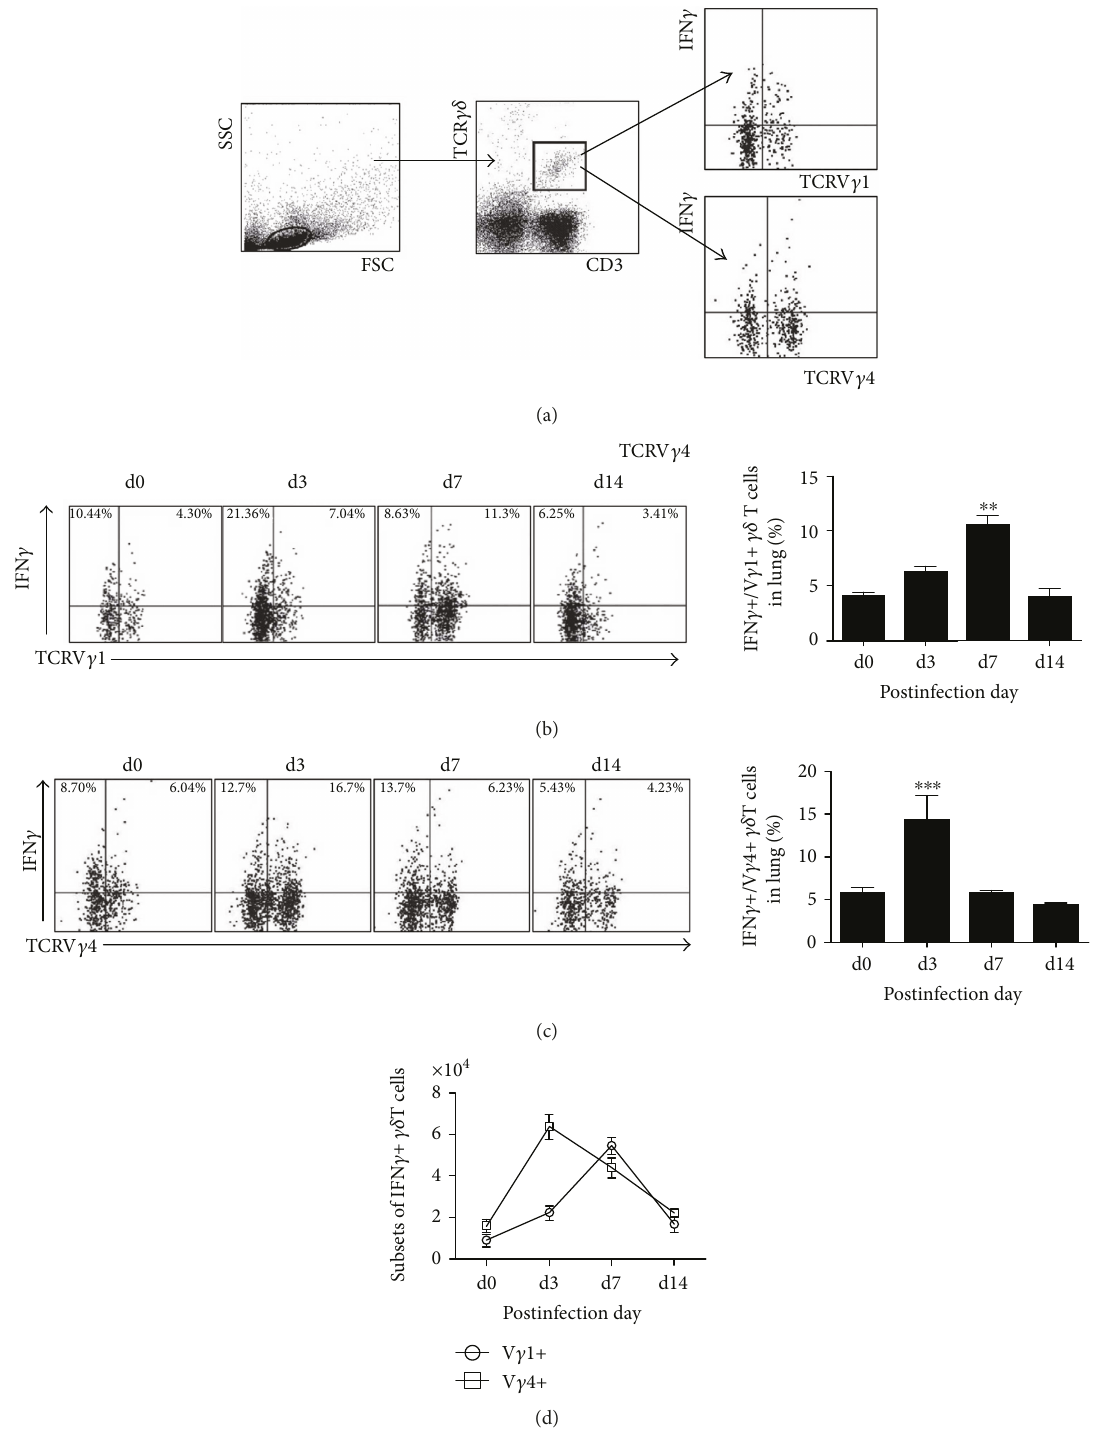
Figure 4: V γ 4 cells at day 3 p.i. and V γ 1 cells at day 7 p.i. are the major sources of IFN γ during Cm lung infection. IFN γ + V γ 1+/V γ 4+ T cells were gated (a). Staining with anti-mouse CD3, TCR γδ , TCRV γ 1/V γ 4, and IFN γ /IL-17 antibody to analyze the percentage and absolute number of IFN γ + V γ 1+ T cells (b) and IFN γ + V γ 4+ T cells (c) in lung tissues after Cm infection by fl ow cytometry. Comparison between IFN γ + V γ 1+ cell and IFN γ + V γ 4+ cell with its absolute number (d). The results are presented as mean ± SD. ∗∗ p < 0 01 and ∗∗∗ p < 0 001